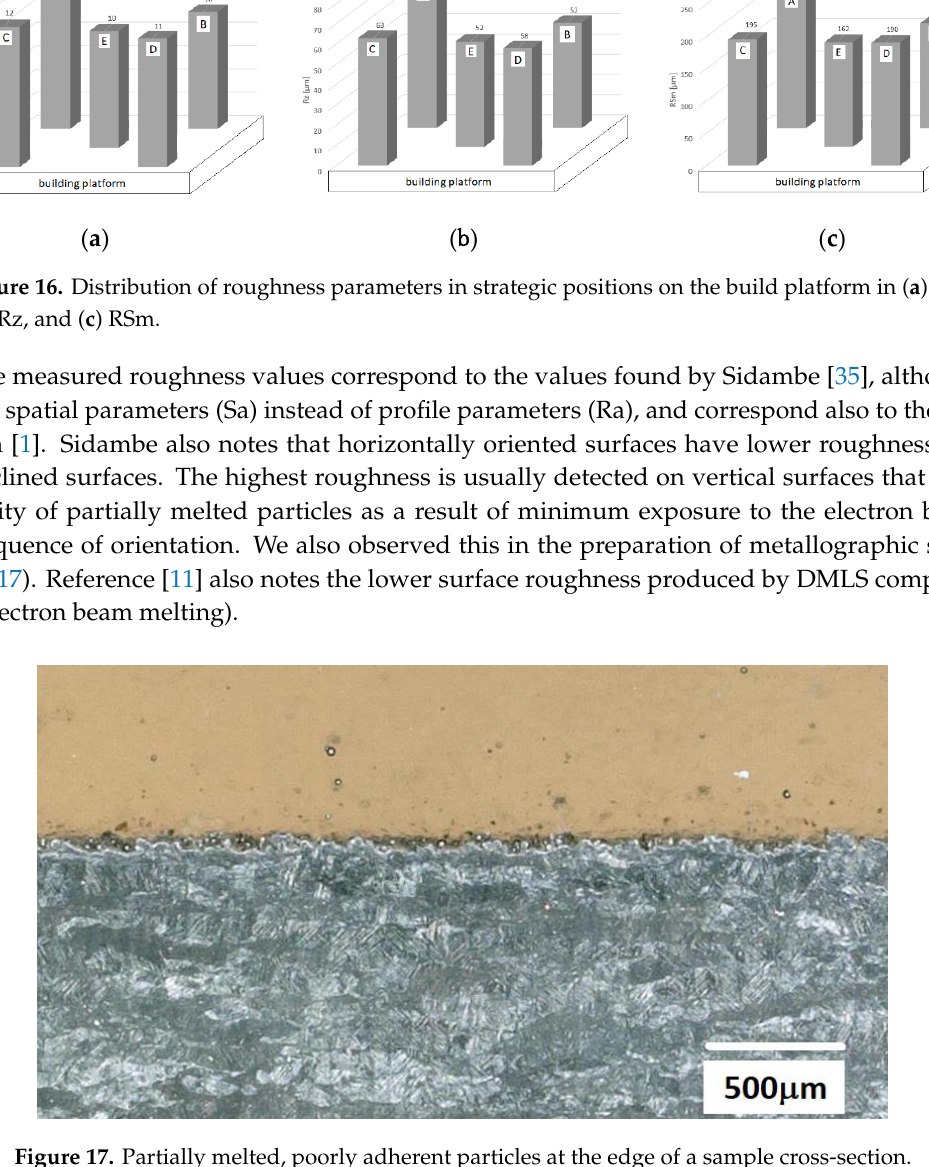
( b ) Figure 15. Distribution of hardness in strategic positions on the build platform in ( a ) ⊥ and ( b ) ‖ directions. 4.2. Roughness of Material The resulting roughness of parts produced in an additive way is always the result of a combination of input parameters — in particular, the particle size of the powder used, melting conditions (laser power and speed, laser scanning strategy, layer height), or orientation of the produced part relative to the building platform [6,32,33]. The roughness affects implant – bone interaction, the friction coefficient, osseointegration process [3,34] (especially in porous structures [4 – 7]), and the fatigue life of the product [11]. Liu [1] notes that the roughness is affected by several factors: (1) the staircase effect related to the subsequently deposited layers; (2) the attachment of the partly melted particles to the surface, and (3) the presence of pores and other imperfections close to surface. She also notes that surface topography is closely related to processing parameters. The authors of this paper tried to find out whether the same surface roughness is achieved under the same production conditions depending on the location on the building platform. The paper evaluates the roughness of material produced by DMLS technology under the same conditions without any additional treatment. The aim was to identify the basic roughness parameters in various positions on the building platform. Figure 16 show that sector A, where the highest values of the parameters Ra,